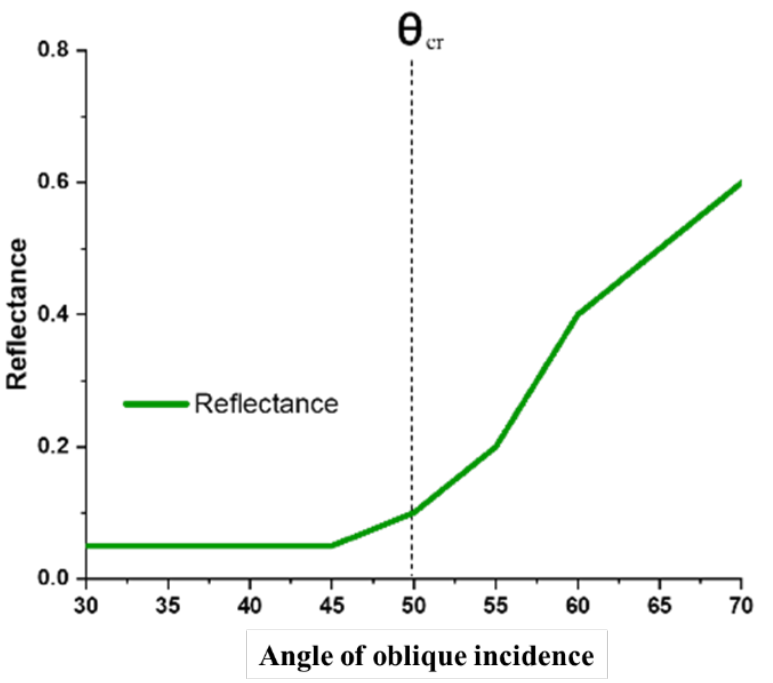
Figure 10. Critical angle of reflection of SiO 2 [36].